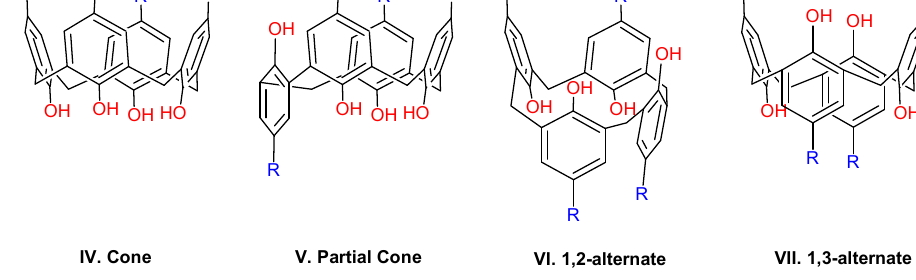
Figure 2. Structures of calix[4]arenes.